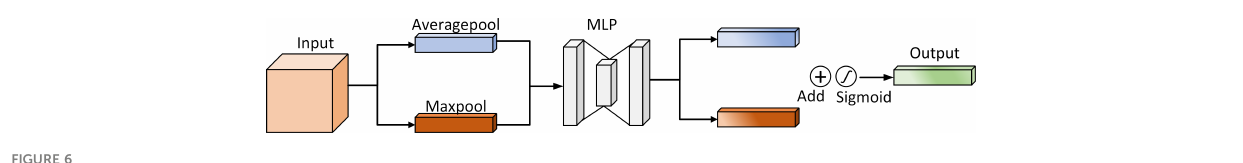
FIGURE 6 The structure of the channel attention module.